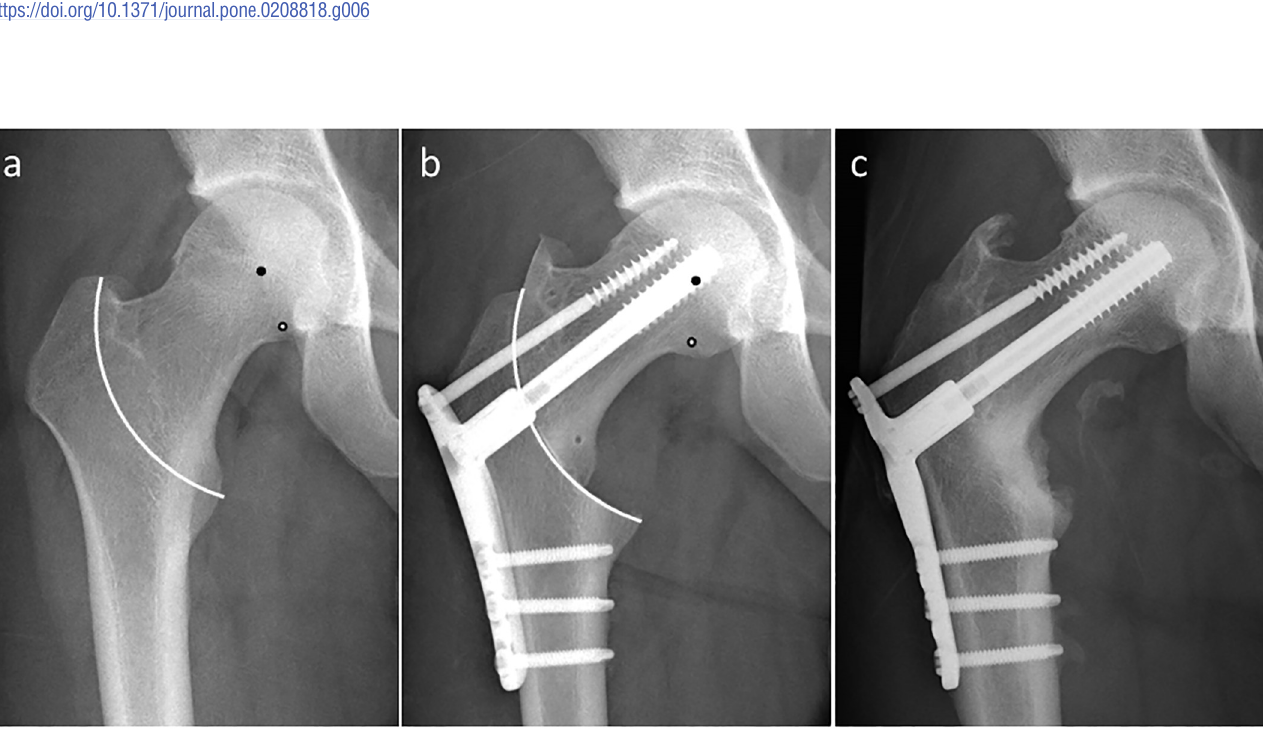
PLOS ONE | https://doi.org/10.1371/journal.pone.0208818 December18,